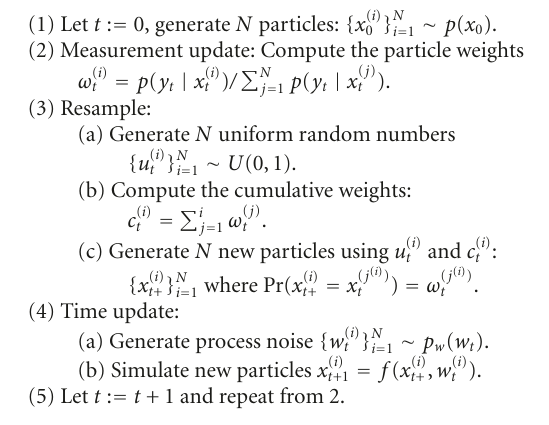
Algorithm 1: The Particle Filter